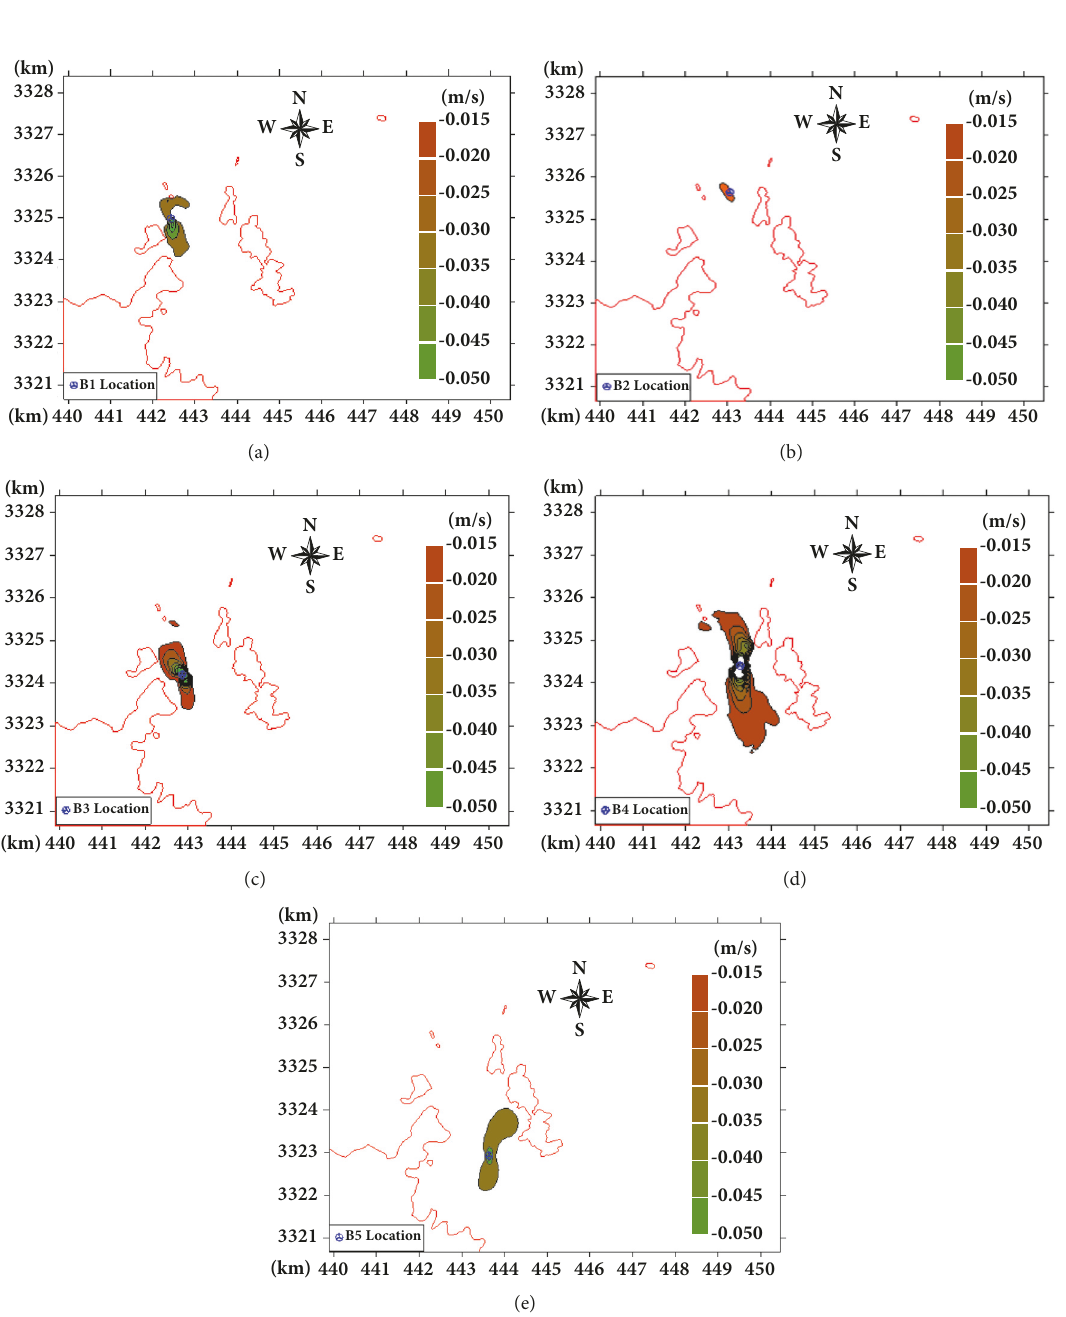
Figure 13: Distribution of maximum difference of flow velocity in (a) B1 location; (b) B2 location; (c) B3 location; (d) B4 location; and (e) B5